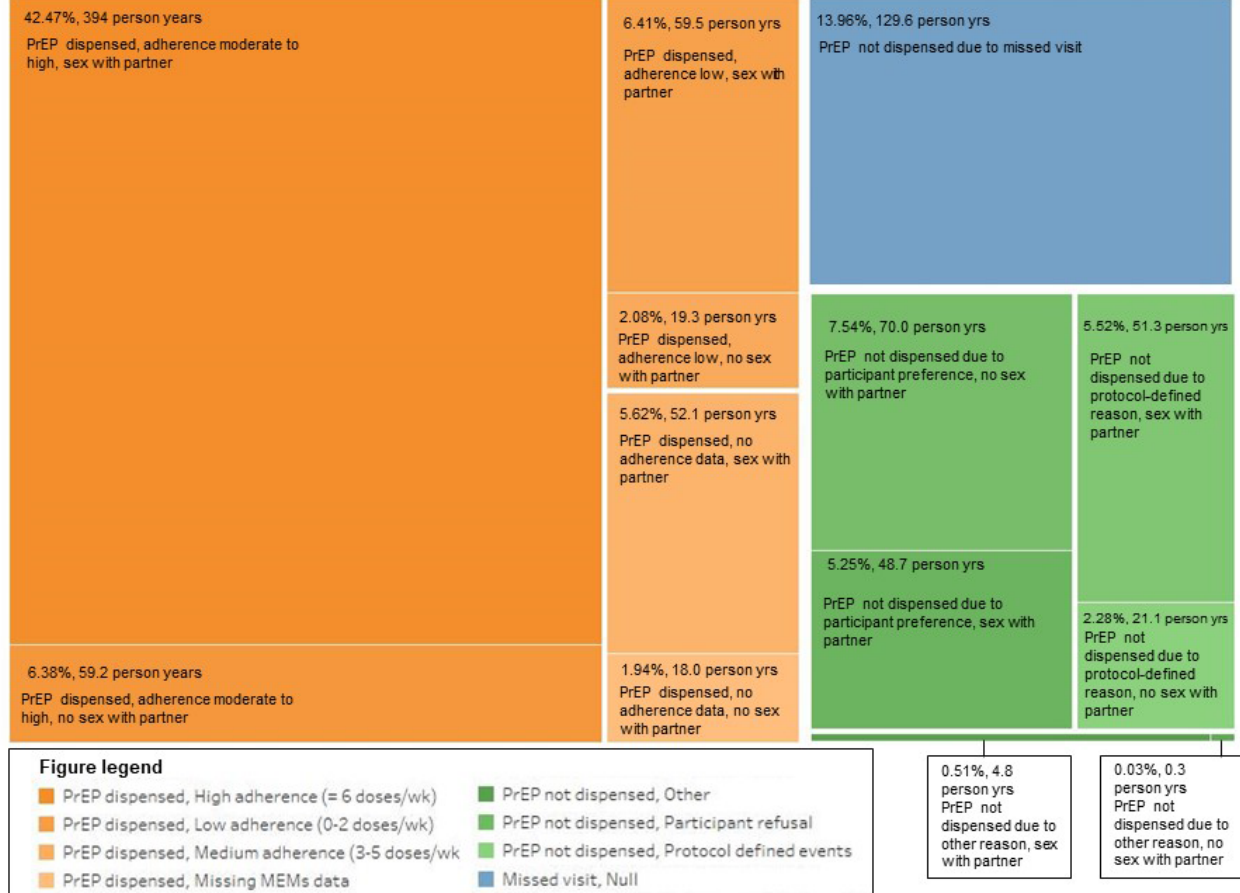
Figure 3. PrEP use by HIV-negative partners from the time of study enrollment through 6 months of ART use by HIV infected partners.